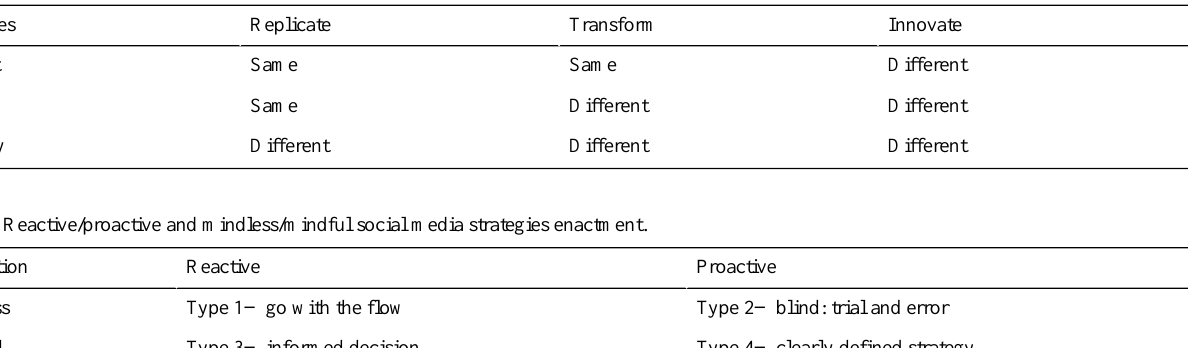
Table 2. Social media strategies: key message characteristics in the synergistic use of information and communication technologies and social media tools.